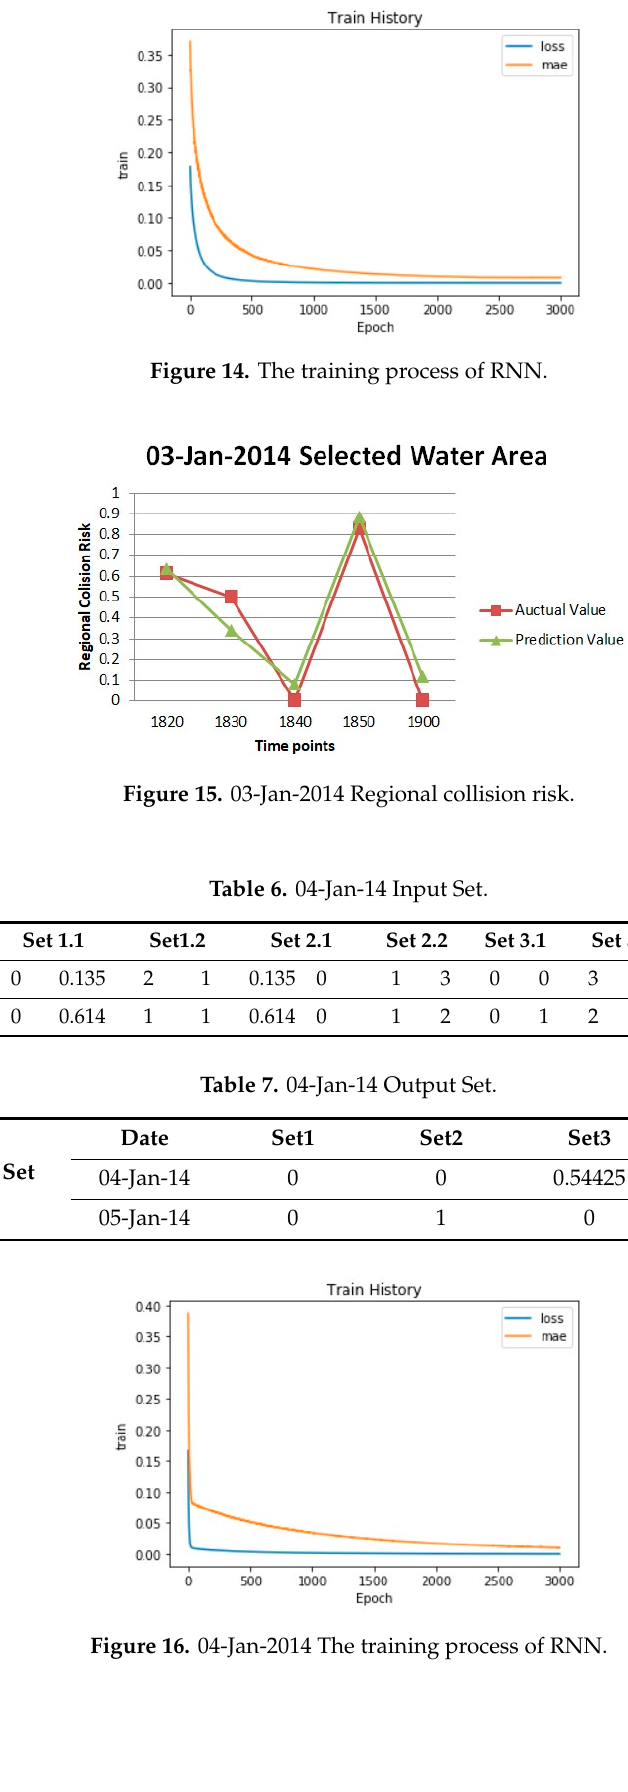
Figure 16. 04-Jan-2014 The training process of RNN.